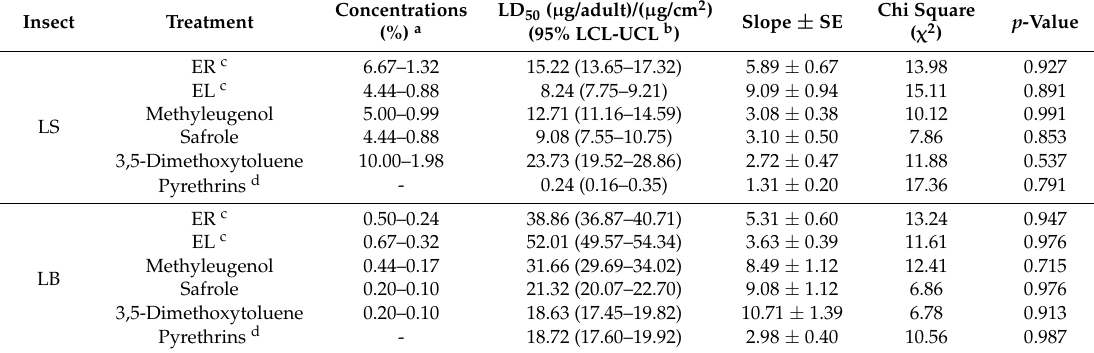
Table 2. Fumigant toxicity of A. heterotropoides essential oil against L. serricorne (LS) and L. bostrychophila (LB).